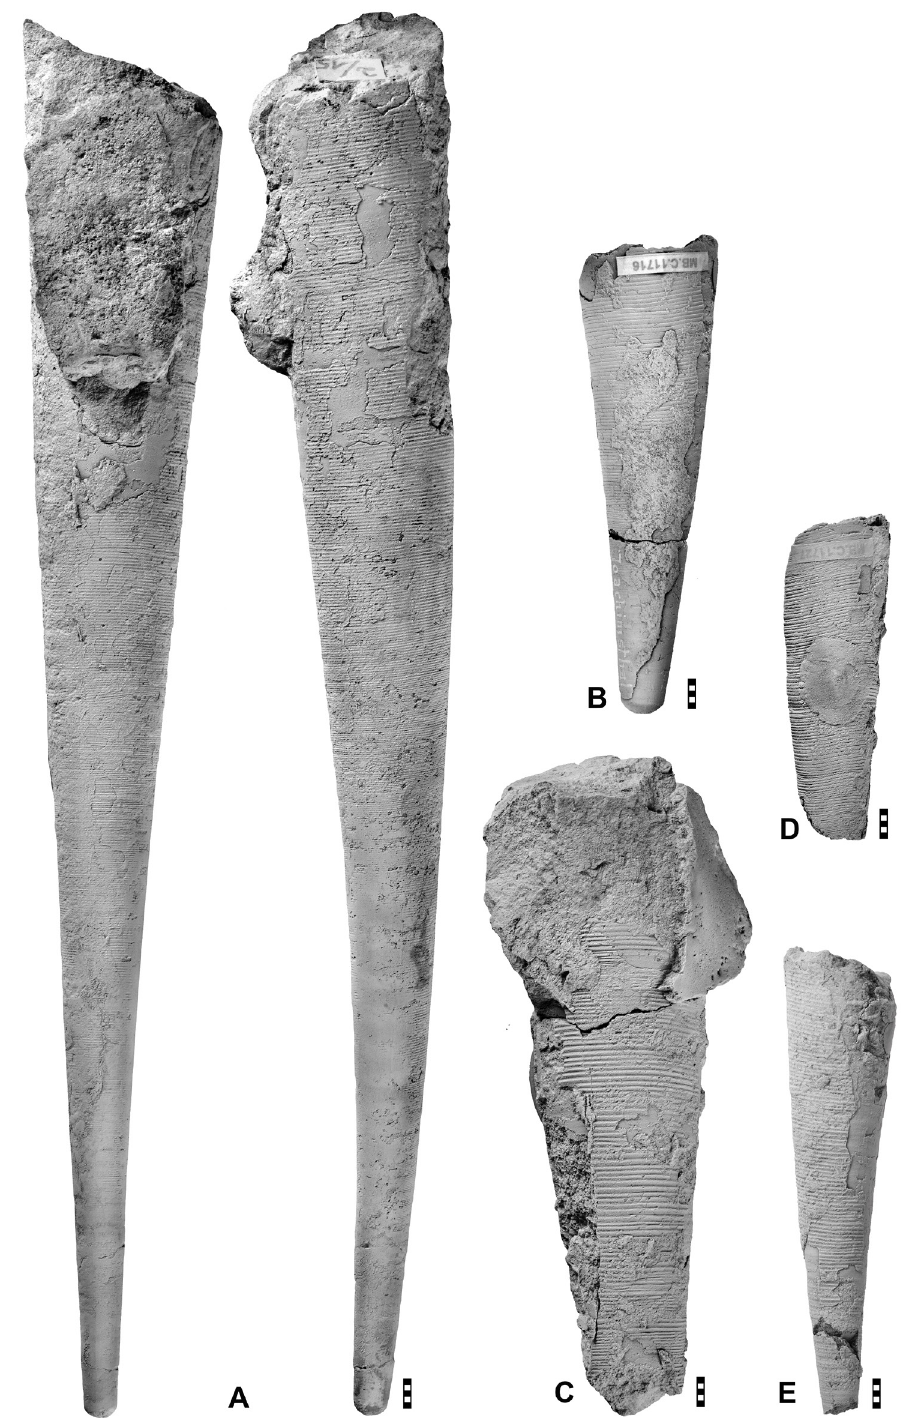
Fig. 10. Rhynchorthoceras angelini (Boll, 1857) from the Upper Red Orthoceratite Limestone. A . Specimen MB.C.29656 (Bottke Coll.) from Skärlöv (Island of Öland); ventral and lateral views. B . Specimen MB.C.11716 (Hentig 1880 Coll.) from Joachimsthal (Brandenburg); lateral view. C . Specimen MB.C.30495.1 from Heegermühle (Brandenburg); dorsal? view. D . Specimen MB.C.11727 (Schmidt Coll.) from near Berlin-Schmargendorf; lateral view. E . Specimen MB.C.11725.1 (Remelé 1879 Coll.) from Heegermühle (Brandenburg); lateral view. Scale bar units = 1